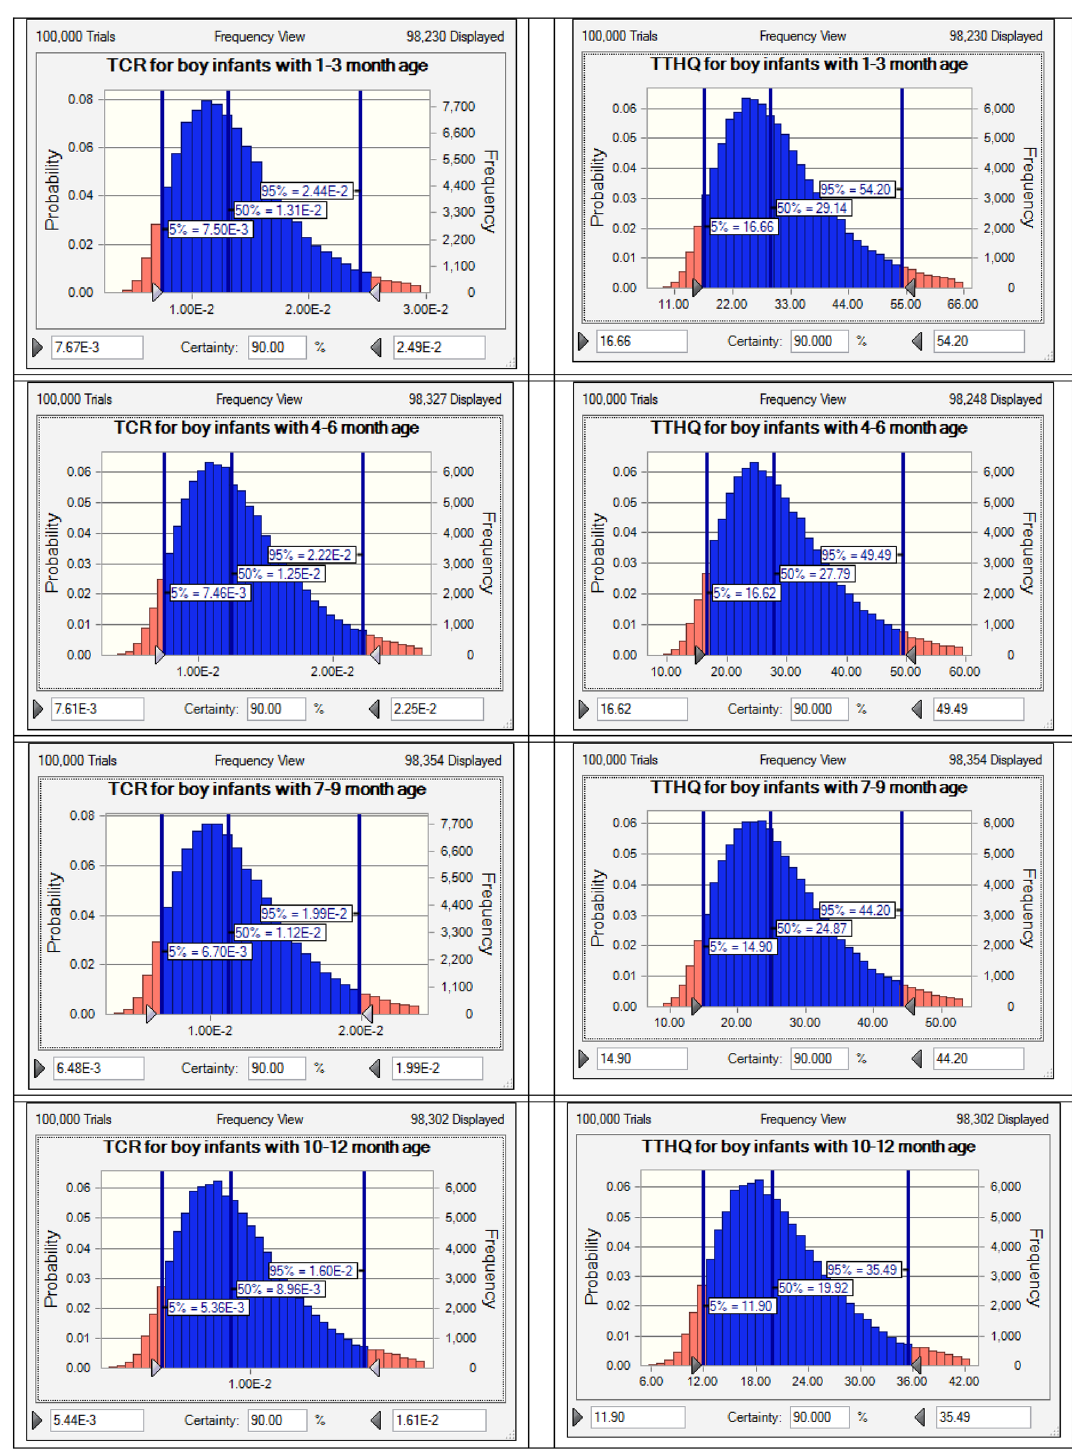
Figure 2. the uncertainty analysis for TTHQ and TCR related to toxic metals of breast milk for boy infants with different